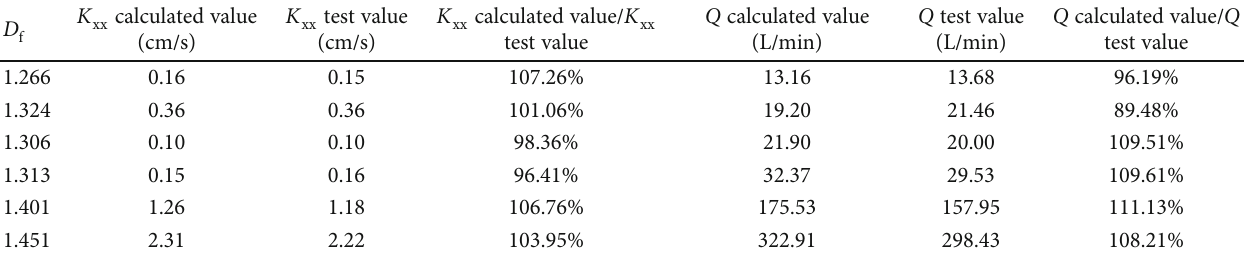
Figure 19: Inner view of di ff erent holes and their fractures developed pattern in di ff erent depth. Table 3: List of theoretical models and water injection